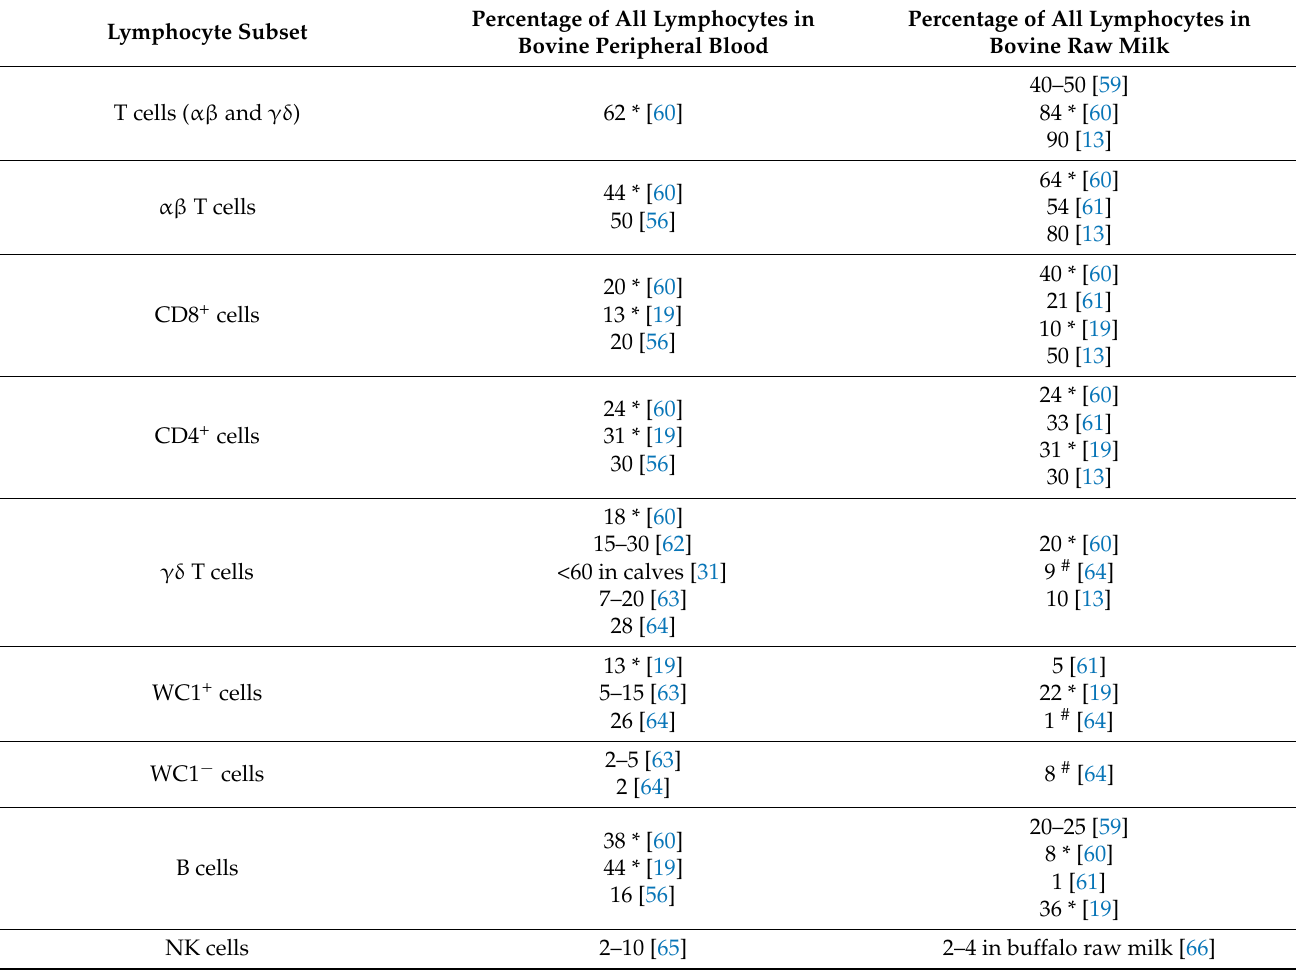
Table 3. Published data on the proportions of different lymphocyte subsets in peripheral blood and raw milk of healthy cows. CD = cluster of differentiation; WC1 = workshop cluster